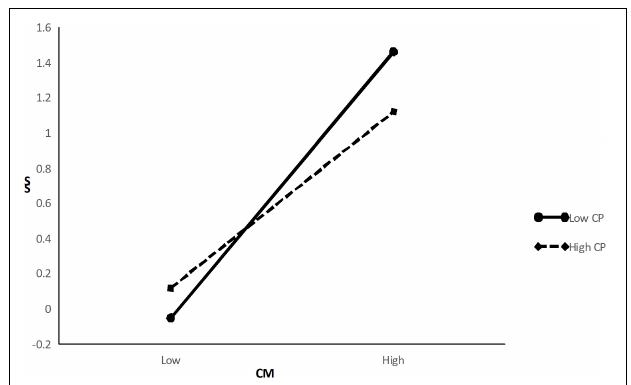
FIGURE 3 | Moderation effects of PR on the WM-SS